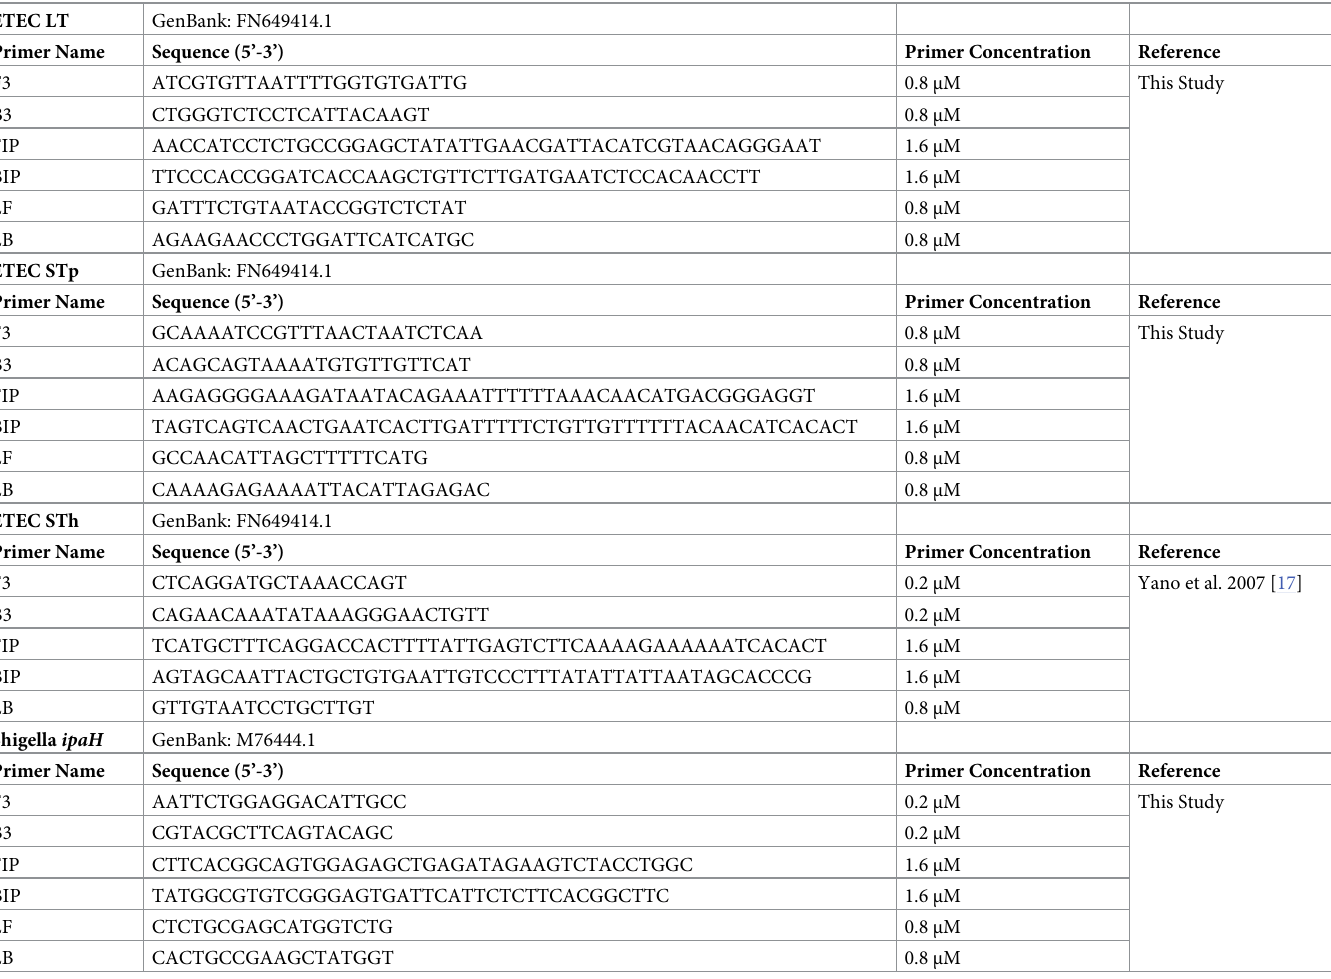
Table 1. List of ETEC and Shigella RLDT primers used in this